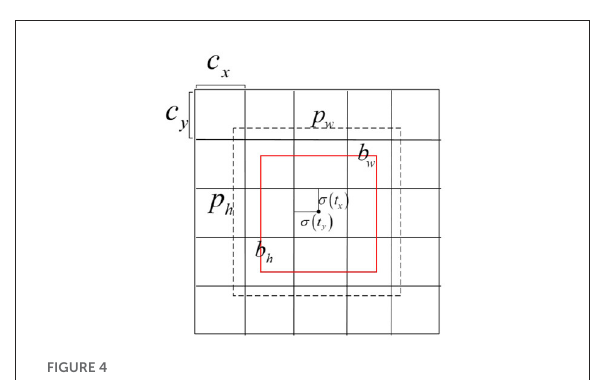
FIGURE4 Schematic diagram of bounding box